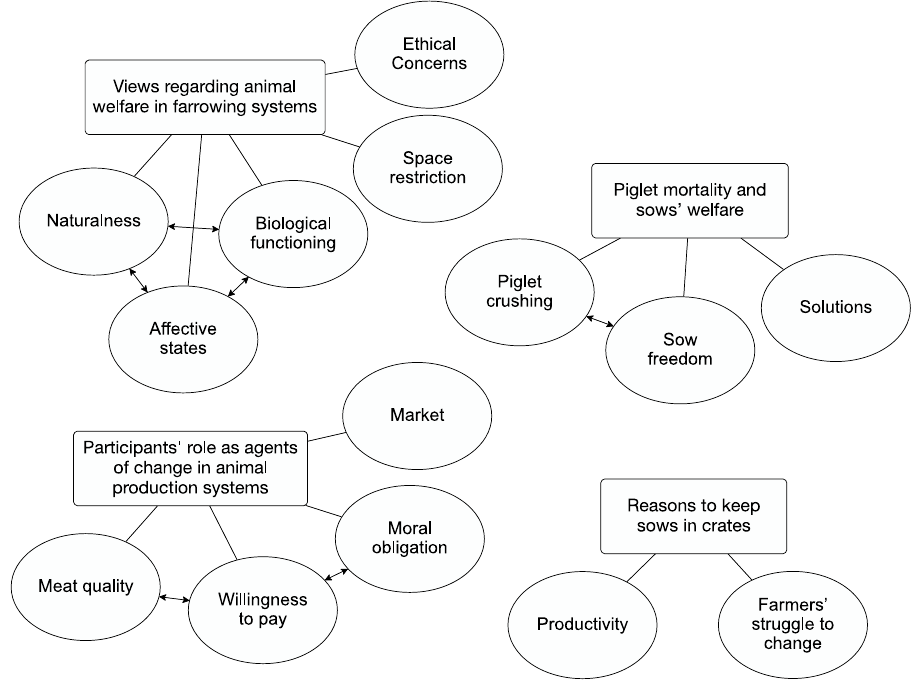
Figure 2. Themes developed based on participants’ open answers. The boxes represent the themes, and the circles represent the underlying codes. The two-way arrows represent relationships between codes.